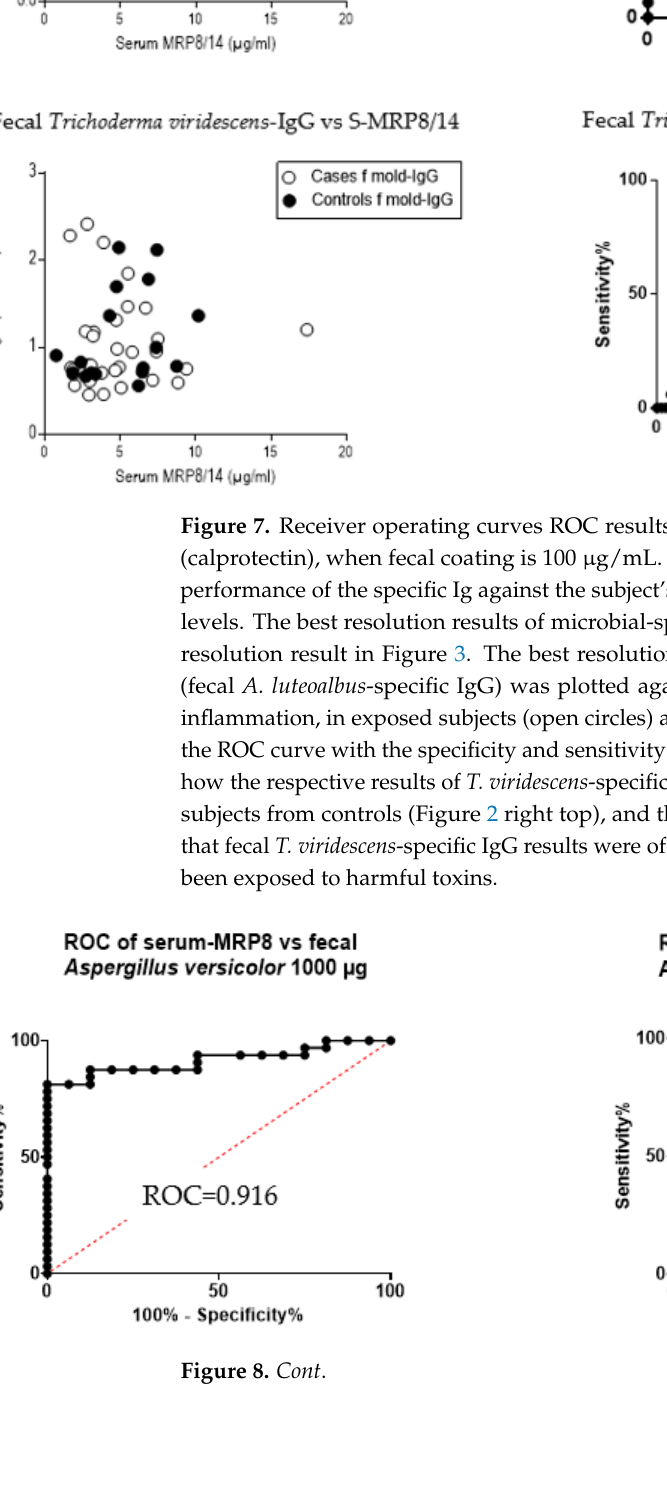
Figure 8. Impact of the protein levels in the coating of the microtiter wells for ROC assays. All the results are from IgD responses of fecal samples against Aspergillus versicolor when plotted against the serum inflammation marker MRP8/14. The amount of the coating extract was studied by con- ducting the assay either in 1000 or 333 µg/mL of A. versicolor extract. 4. Discussion This study aimed to develop assays for the clinical diagnostics of dampness and mold hypersensitivity syndrome (DMHS). The approach was to examine isolated and pure cul- tured toxic molds of a “sick building”, the immunological response of the mold-exposed vs. controls, and furthermore not simply to use some generally well-known mold prepa- rations. Based on earlier publications, the presence of molds is not the issue; instead, it should be the existence of fungal metabolites excreted by actively growing molds, possi- bly including mycotoxins, biosurfactants, and enzymes [14]. According to the results pub- lished in a doctoral dissertation made from the same target building, the vast majority, i.e., >70% of the tested microbial colonies were toxic when examined in cell tests [14]. According to the results presented here, the studied building was clearly toxic in many respects: severe symptoms reported by >90% of the employees, which were con- firmed objectively in various in vitro tests. 4.1. BAT Results Confirm the Toxicity of the Studied Mold Strains The promising results emerging from food allergy and non-IgE-dependent basophil activation tests (BAT) formed the basis for decision to utilize the BAT in this hotly debated topic of how best to assess poor indoor air quality. Furthermore, in the earlier study of Mirkovic et al., BAT discriminated A. fumigatus -sensitized from non-sensitized cystic fi- brosis patients. The basophil activation marker used here (CD203c) was different from that used by Mirkovic (CD63), this technical difference is not responsible for the major